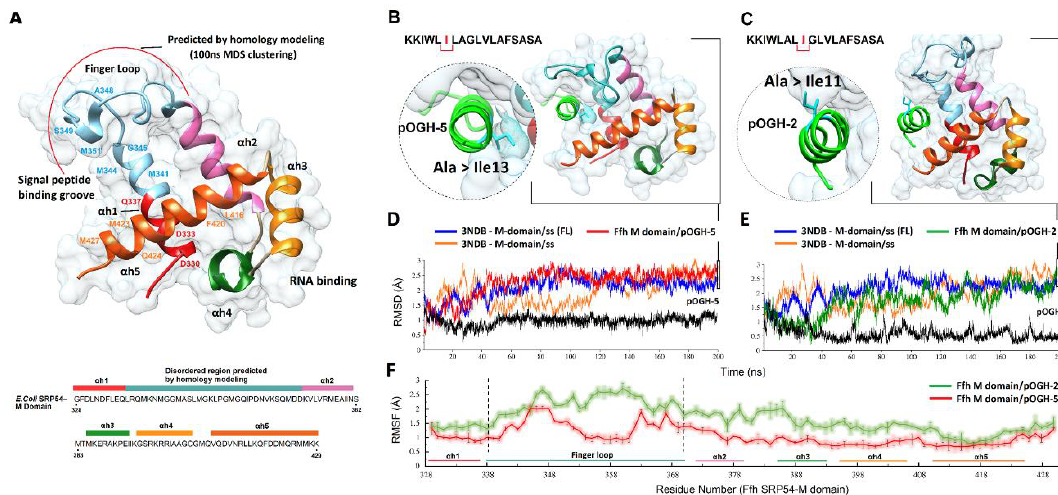
Figure 4. ( A ) The ribbon representation of the fifty-four homolog (Ffh) M-domain is enclosed by a molecular surface in white. The polypeptide chain is ramp-colored from red (N-terminal) to orange (C-terminal). The five alpha helices are rendered and colored accordingly ( α h1—red, α h2—pink, α h3—green, α h4—golden, α h5—orange). The missing disordered region near the peptide binding groove is predicted by comparative homology modeling using HHpred and colored blue with the curved red line indicating the modeled portion. The two alpha helices ( α h1 and α h5) and finger loop making up a signal peptide binding groove with key residues are labeled. The right panel shows the molecular dynamics simulated complexes of M-domain with pOGH-5 ( B ) and pOGH-2 ( C ) obtained after a 200 ns production run. This is followed by root mean square deviation (RMSD) trajectories in time-dependent manner (ns) of pOGH-5 ( D ) and pOGH-2 ( E ), with red and green color representing the M-domain and docked peptide in black. The RMSDs of the reference structure (3NDB) bound to signal sequence with (blue) or without the finger loop (FL) (orange) are also displayed. ( E ) Per-residue fluctuations of the M-domain throughout 200 ns are plotted for pOGH-5 (red) and pOGH-2 (green) along with the error bars calculated by comparing trajectories in different time frames, while the corresponding helices and finger loop regions are underlined with the same color code.